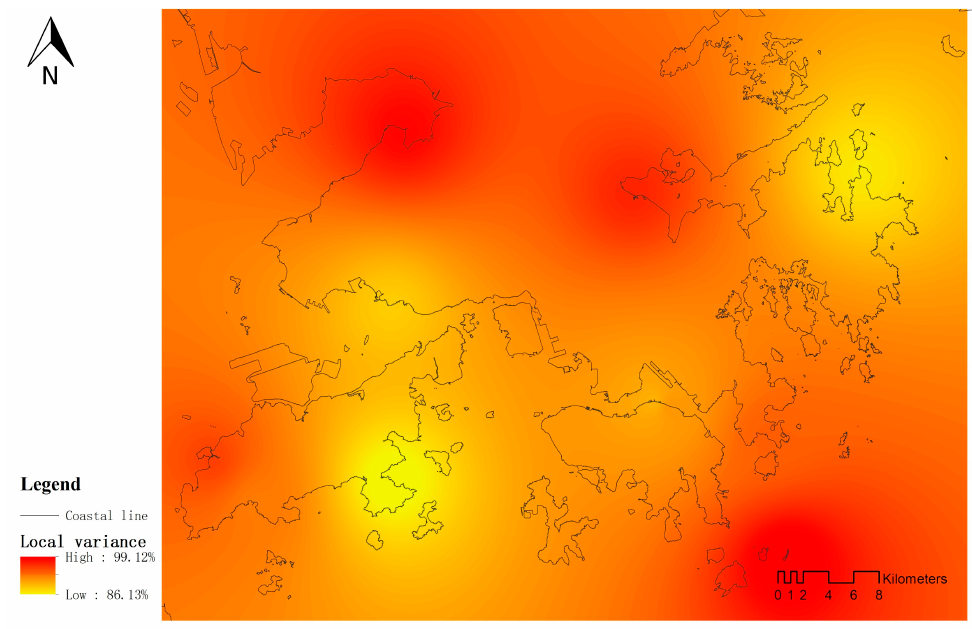
Figure 5. Local variance of ESL.